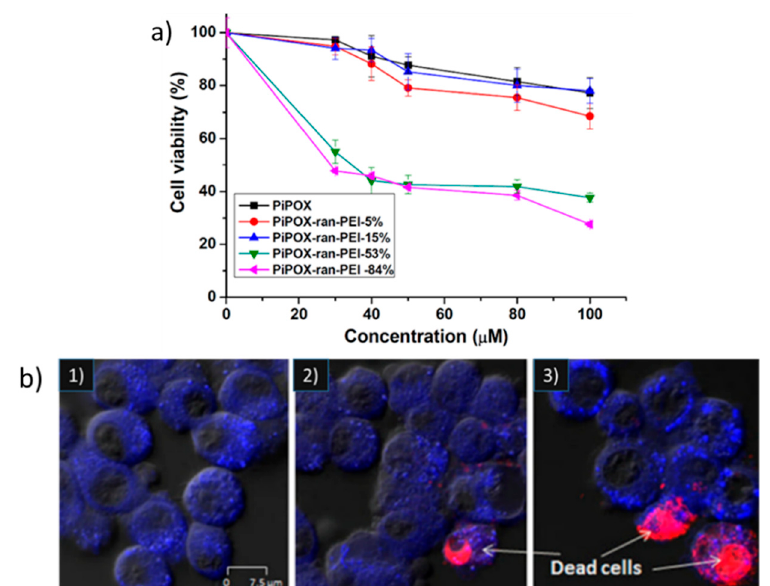
Figure 6. Cytotoxicity of POx–PEI copolymers. ( a ) Poly(iso-propyl-2-oxazoline) (PiPOx)–PEI copolymers differing by DH determined by MTT (3-(4,5-dimethyldiazol-2-yl)-2,5-diphenyltetrazolium bromide) dye reduction assay against the HEK 293 cell line. Adapted from Toncheva-Moncheva et al. as published by Elsevier [42]; ( b ) Confocal laser-scanning microscopy of macrophages P388.D1 treated with pure poly(2-ethyl-2-oxazoline) (PEtOx), PEtOx–PEI of 14, and 59% DH corresponding to images 1, 2 and 3, respectively. Adapted from Shah et al. as published by the Springer Nature [46]. Table 3. Cell viability variations determined by MTT dye reduction assay for POx–PEI copolymers di ff ering by their alkyl substituents. The copolymers are selected to be comparable by DP ( ≈ 70) and DH ( ≈